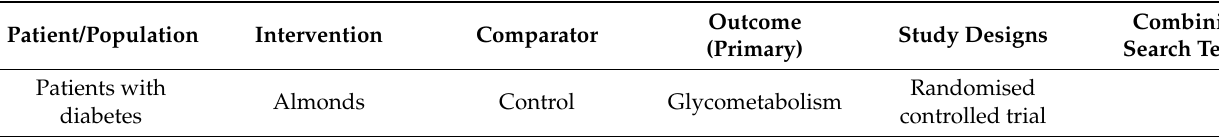
Table 1. Search terms and search